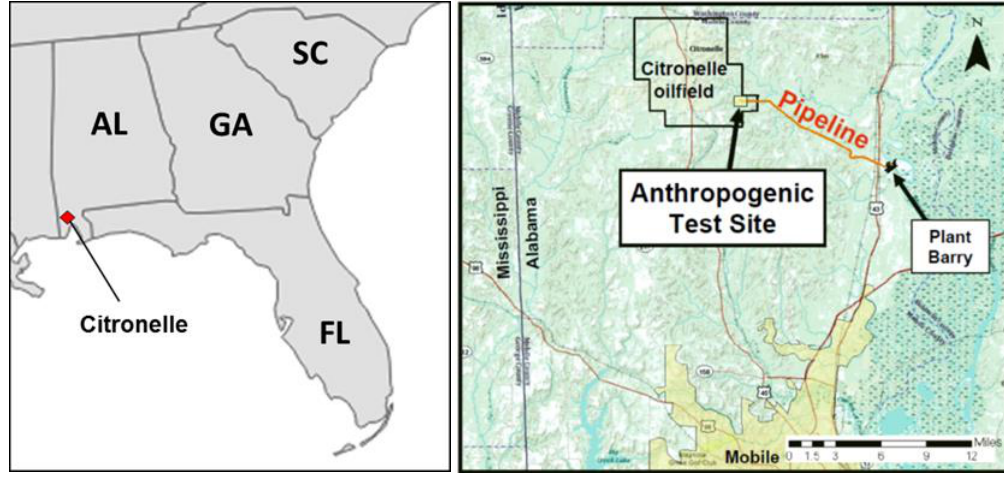
Figure 1 . Location map of the Anthropogenic Test Site, the Citronelle oilfield, and Plant Berry.